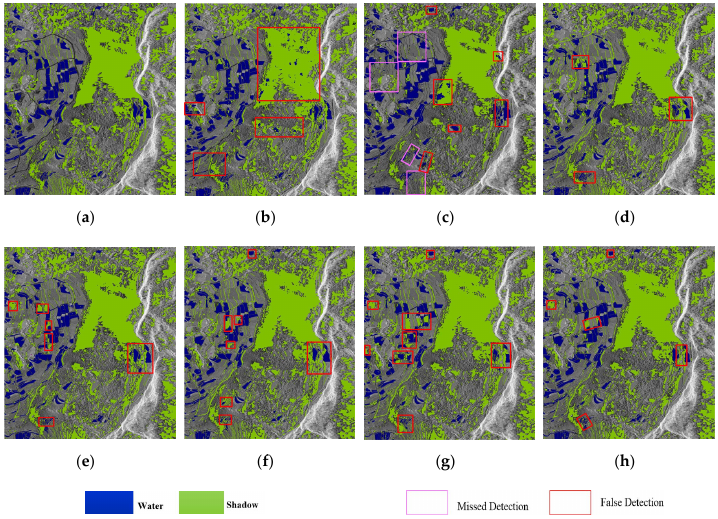
Figure 12. The fusion map of classification results by different methods. ( a ) Ground truth. ( b ) RefineNet. ( c ) DeepLabV3. ( d ) Multi-Level Selective Attention Network (MLSAN). ( e ) GLGCM-MLSAN. ( f ) Gabor-MLSAN. ( g ) MSOGDF-MLSAN. ( h ) MSF-MLSAN.